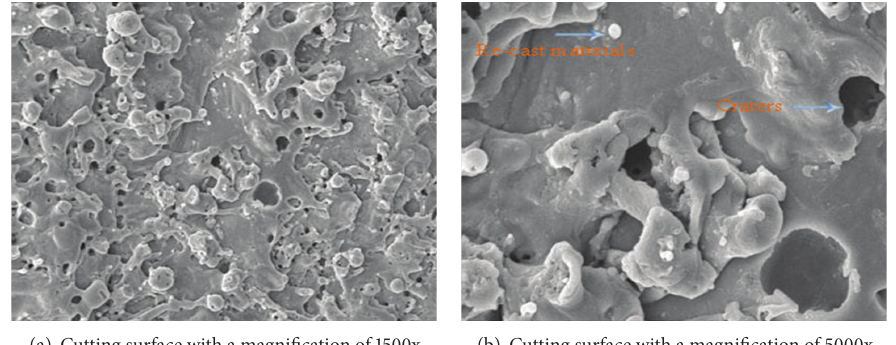
Figure 3: SEM images of Nitinol-60 cut surface with WEDM.